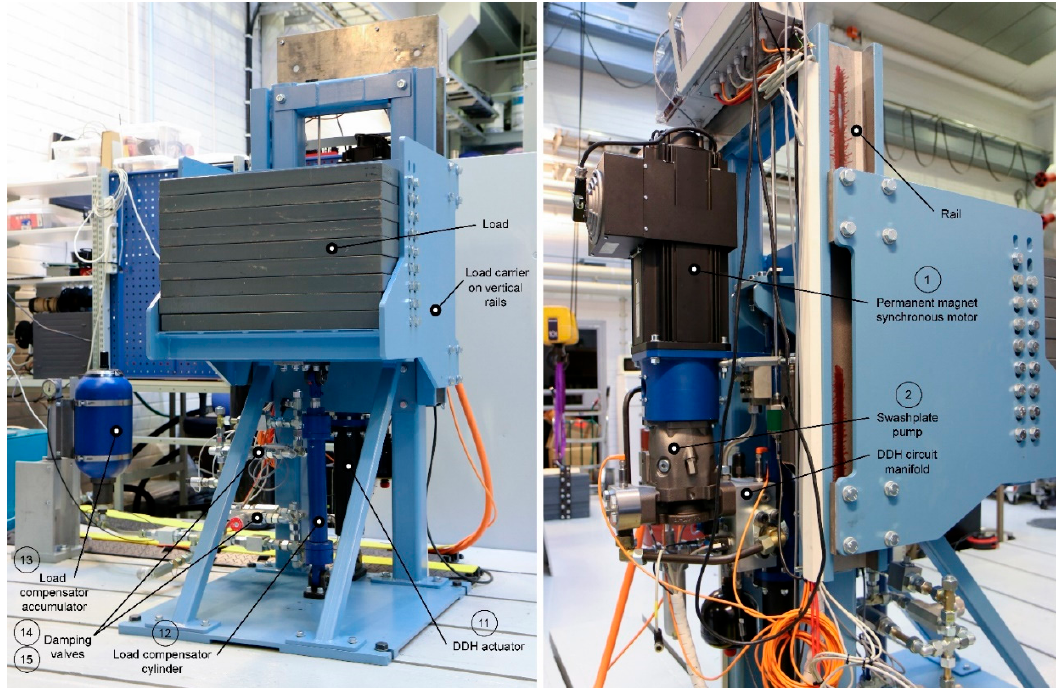
Figure 1. Vertical motion test rig containing the DDH and load compensation systems.